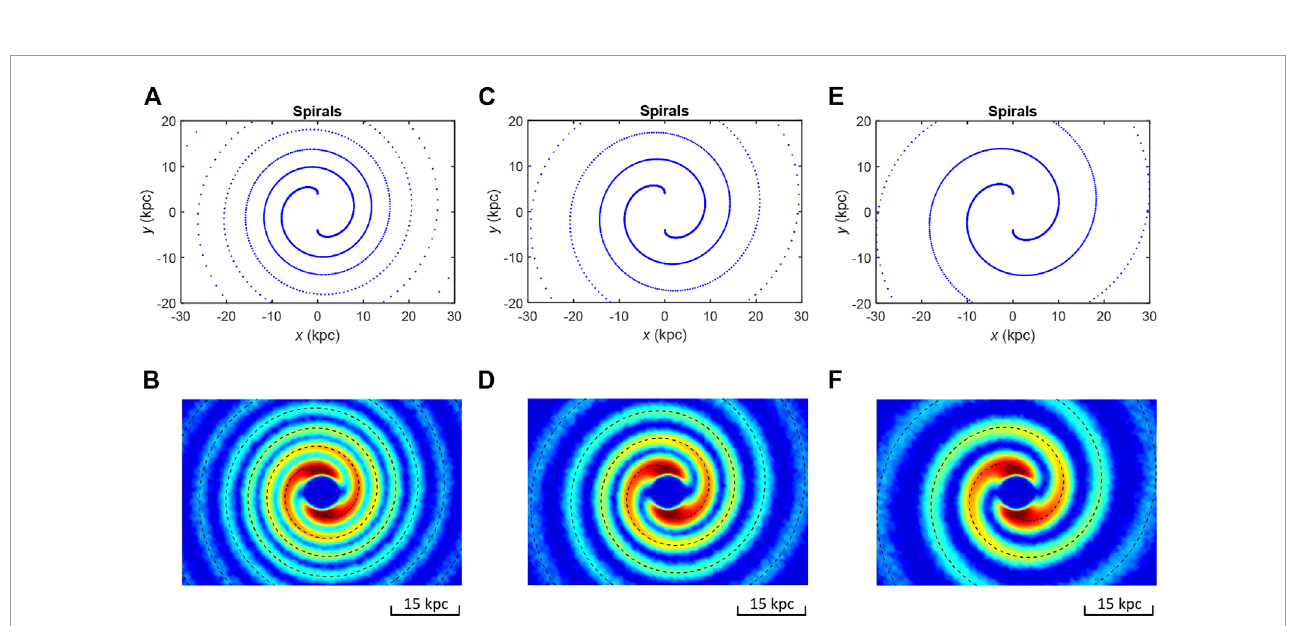
FIGURE 7 Geometry of spirals: dependence on the galaxy mass. The critical radius R c , the galaxy age and the maximum redshift are 4 kpc, 8.8 Gyr and z = 11 . 18. The upper/lower plots show orbits with unperturbed/perturbed parameters R c and ϕ . The masses of the bulge and disk are M b = 17 × 10 9 M ⊙ and M d = 17 × 10 10 M ⊙ in (A, B) , M b = 8 . 5 × 10 9 M ⊙ and M d = 8.5 × 10 10 M ⊙ in (C, D) , and M b = 4.25 × 10 9 M ⊙ and M d = 4.25 × 10 10 M ⊙ in (E, F) . The rotation velocity V ϕ is 307.9 km/s in (A, B) , 217.7 km/s in (C, D) , and 153.9 km/s in (E, F)